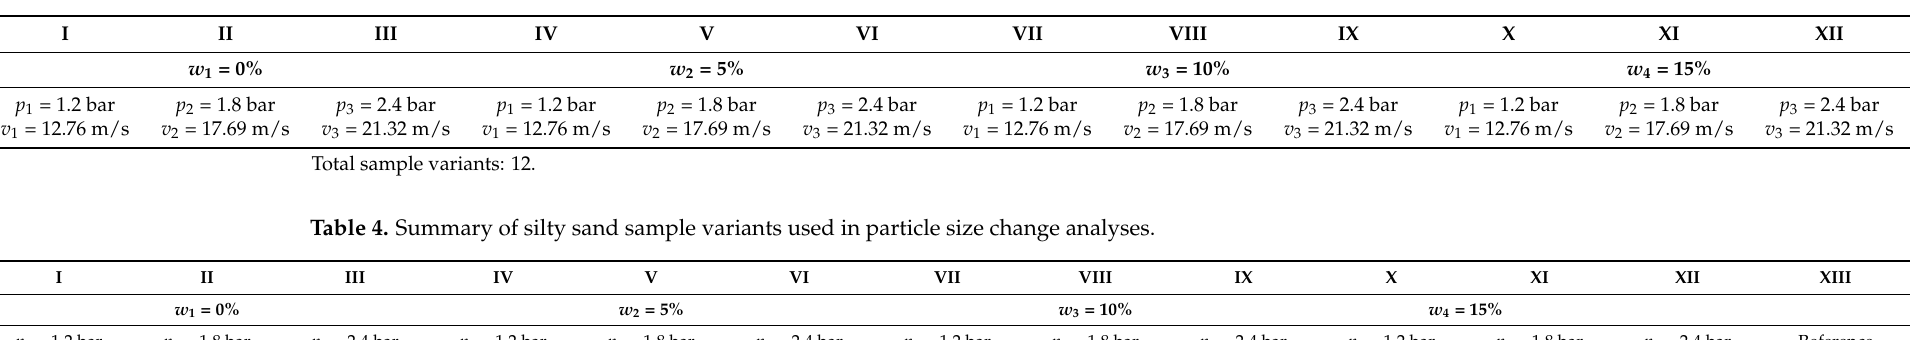
Table 3. Summary of silty sand sample variants used in experiments conducted on the SHPB test stand.